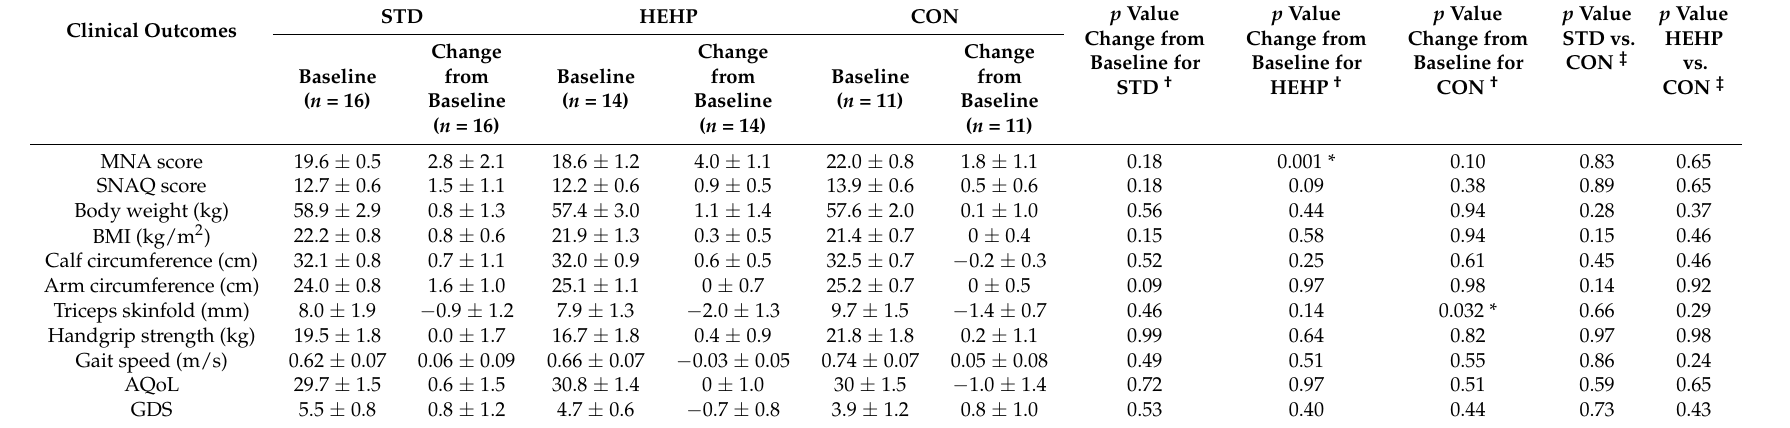
Table 4. Clinical outcomes at baseline and week 12 for STD, HEHP, and CON ˆ#